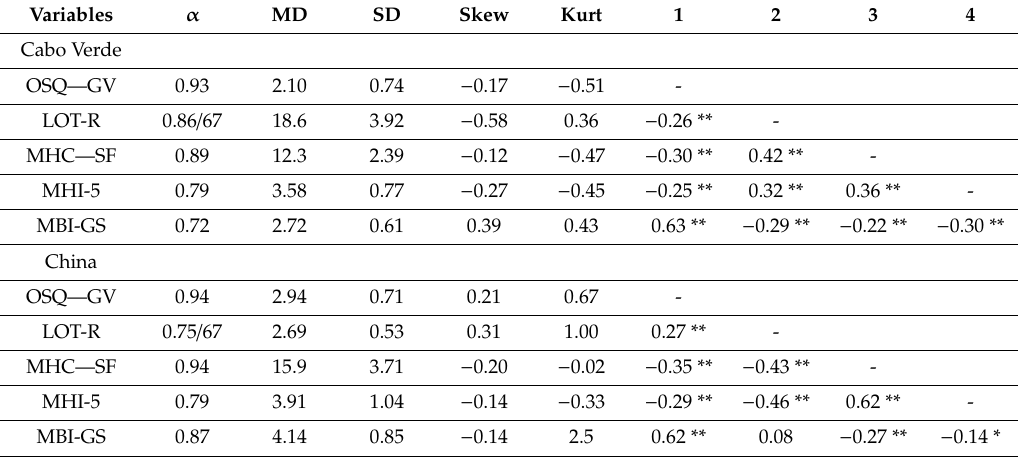
Cronbach’s alpha coe ffi cients, the means, the standard deviations and the Pearson correlation coe ffi